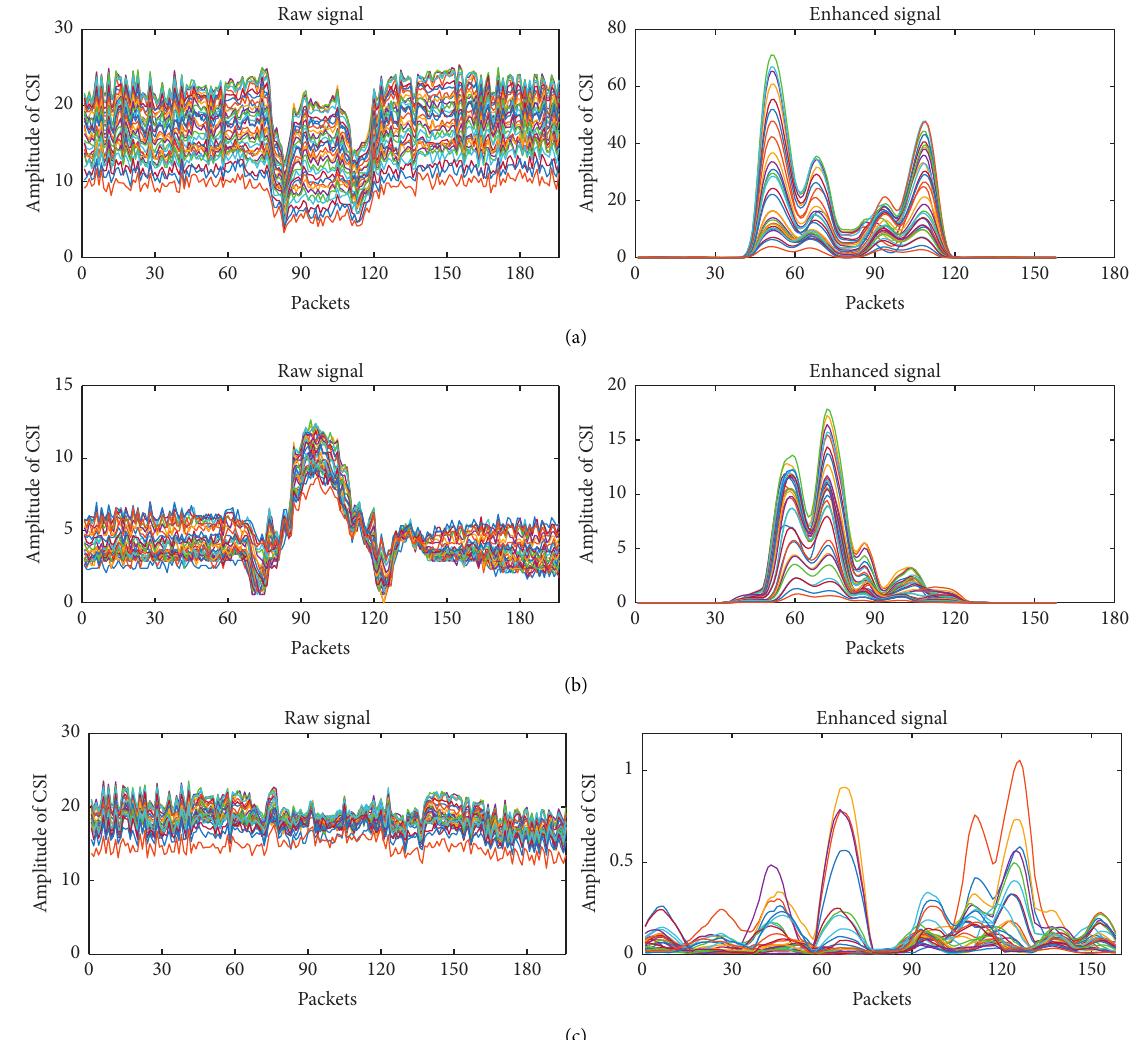
Figure 7: Three antennas raw signal and enhanced signal of bend movement based on NISE. (a) First antenna; (b) second antenna; (c) third